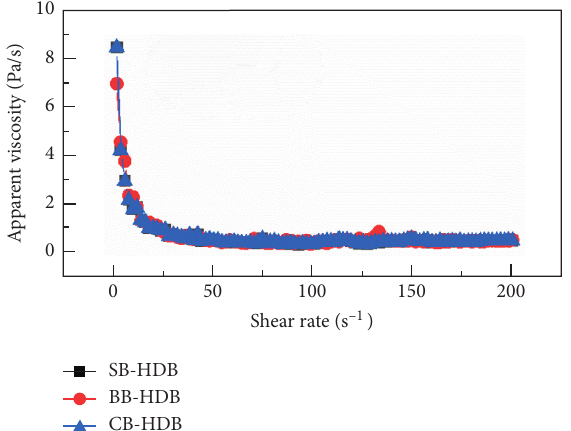
Figure 7: Apparent viscosity for SB-HDB, BB-HDB, and